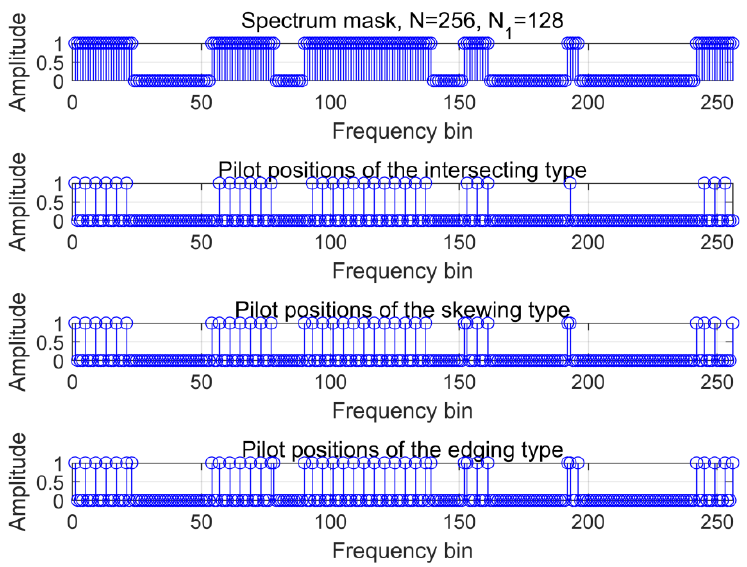
Figure 4. The non-uniform pilot positions within the bandwidth.